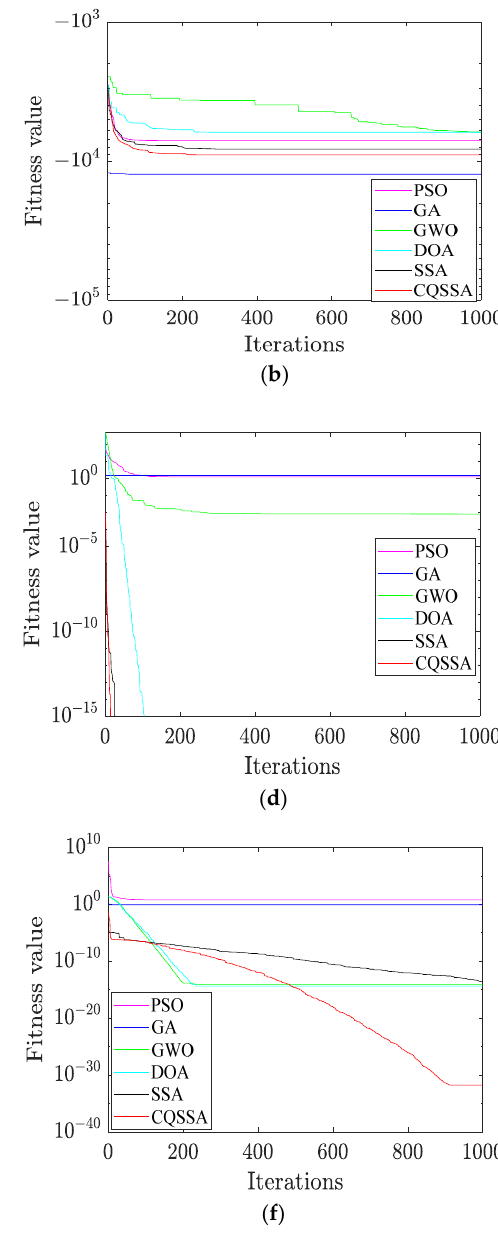
Figure 3. The convergence characteristics of the six algorithms under six test functions. ( a ) The convergence curve of algorithms on F1. ( b ) The convergence curve of algorithms on F2. ( c ) The convergence curve of algorithms on F3. ( d ) The convergence curve of algorithms on F4. ( e ) The convergence curve of algorithms on F5. ( f ) The convergence curve of algorithms on F6.